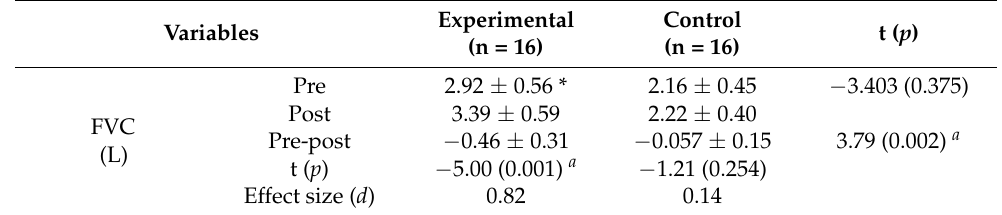
Table 5. Comparison of cardiopulmonary function within and between